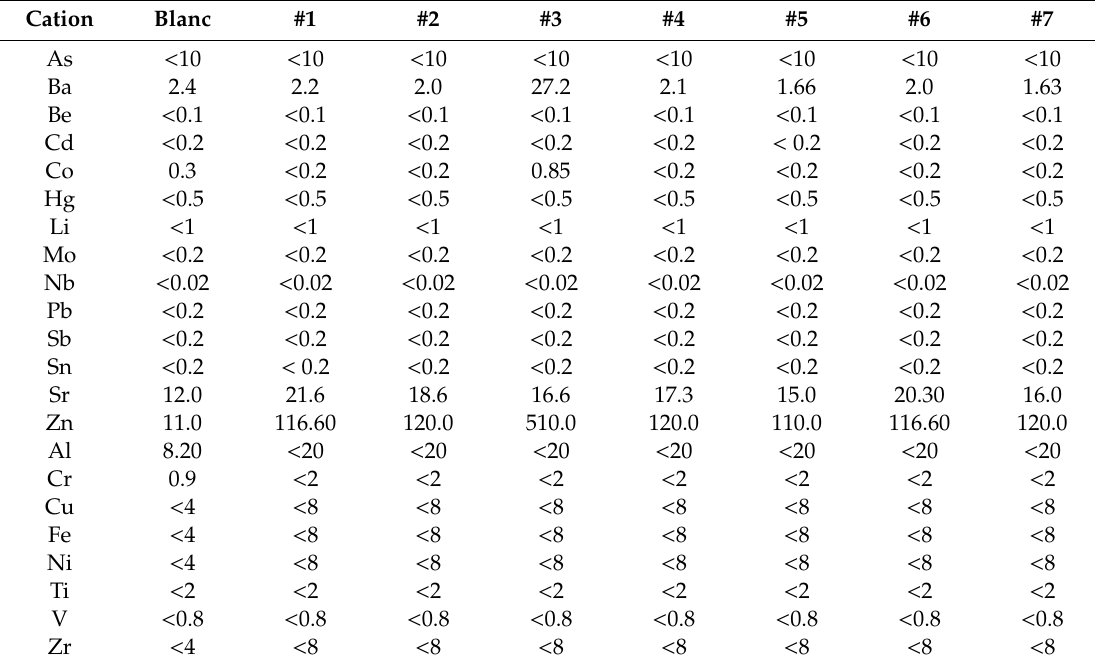
Table 8. Quantities of cations released from Ti-based alloys ( µ g /